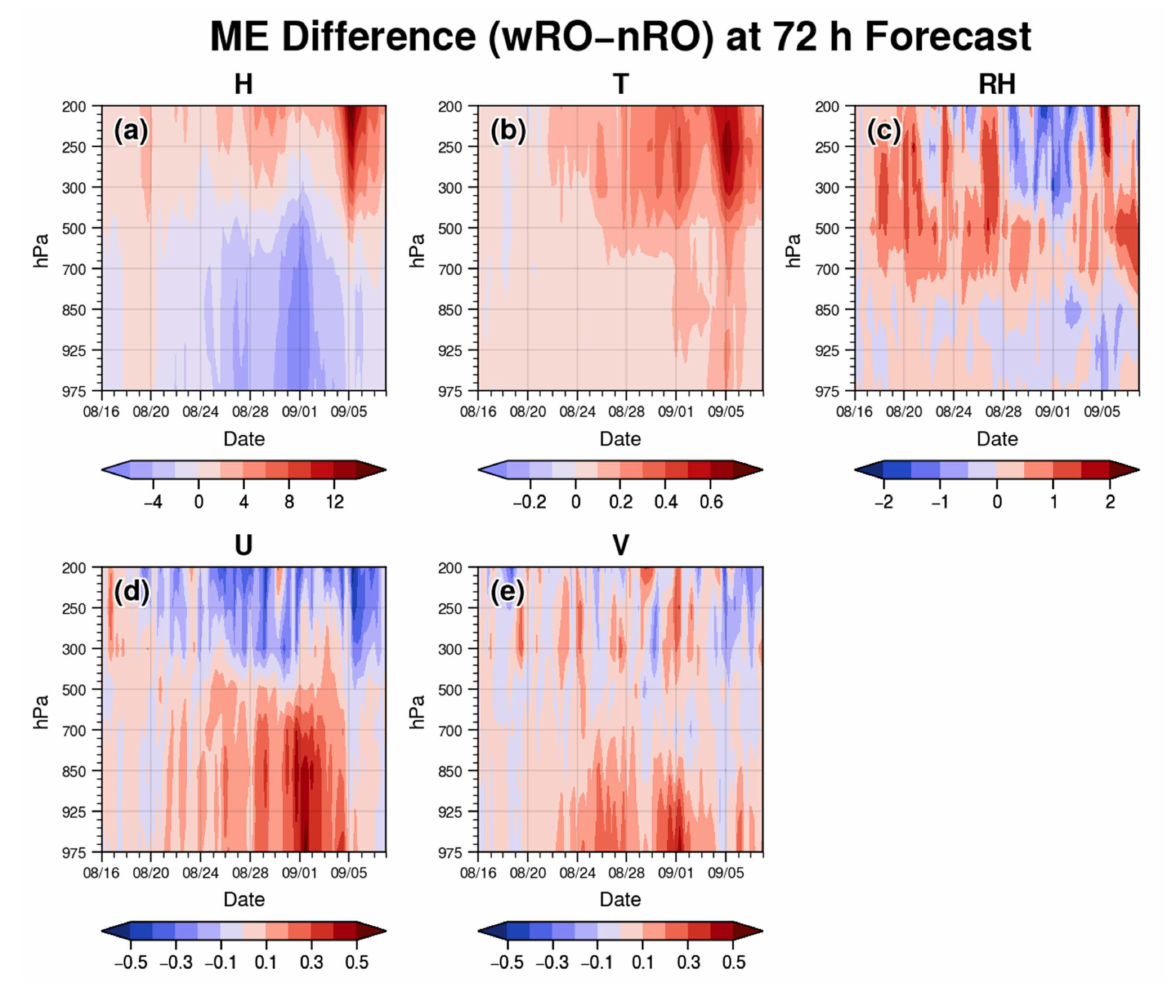
Figure 7. ME difference of 72-h forecast grid verification between nRO and wRO against 0.25 ◦ × 0.25 ◦ NCEP GFS analysis. The vertical profiles vary with the 93 initial time during the experiment period in ( a ) geopotential height (H, unit: meter), ( b ) temperature (T, unit: K), ( c ) relative humidity (RH, unit: %), and ( d ) u and ( e ) v wind speed (U and V, unit: m/s),